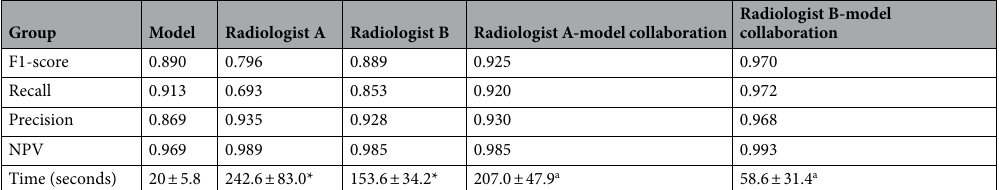
Table 3. The comparison of the performance between the model, radiologist and radiologist-model collaboration. NPV negative predictive value. *Indicated the p value of the comparison between model and radiologists was < 0.001. a Indicated the p value of the comparison before and after using the model was < 0.001.